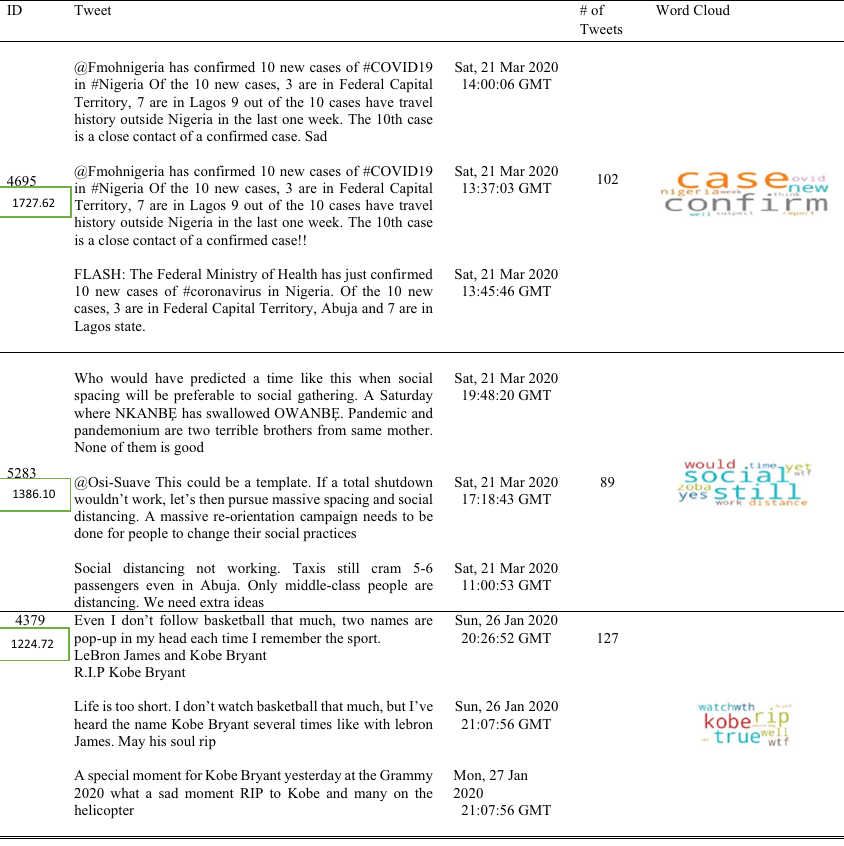
Word Cloud Tweets